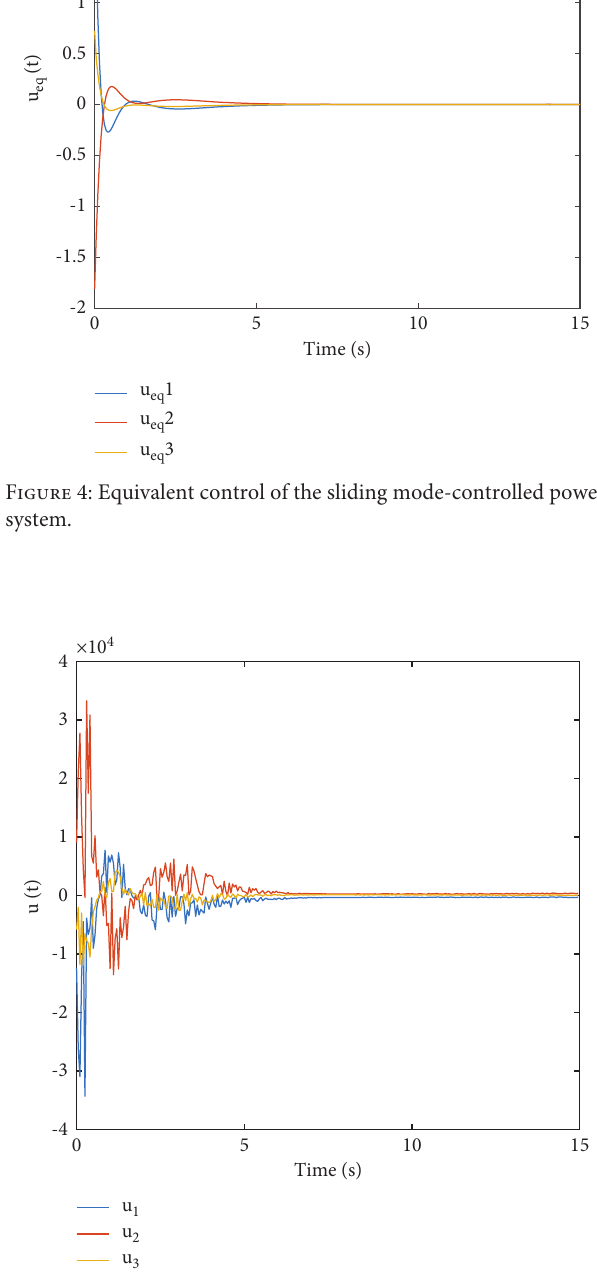
Figure 5: State of sliding mode control